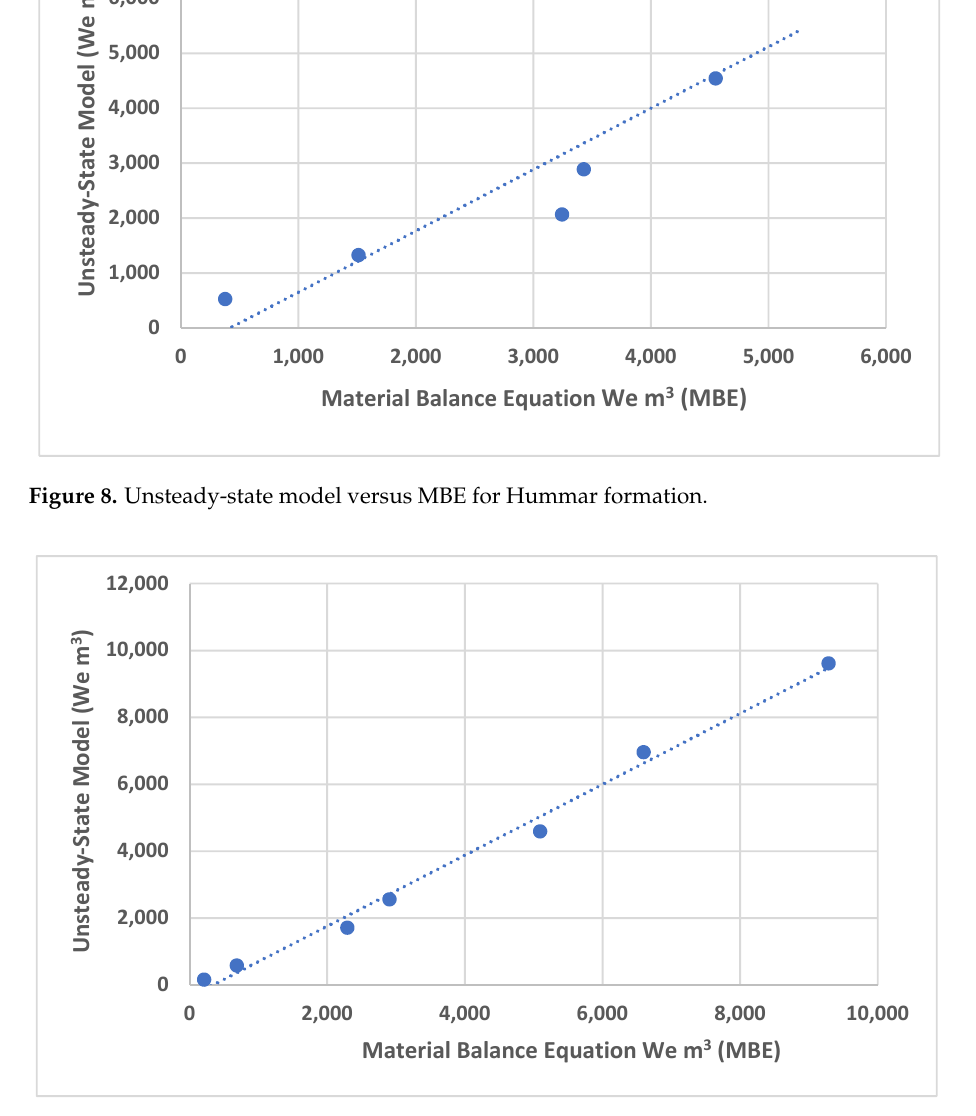
Figure 9. Unsteady ‐ state model versus MBE for Shueib formation. Figure 9. Unsteady-state model versus MBE for Shueib